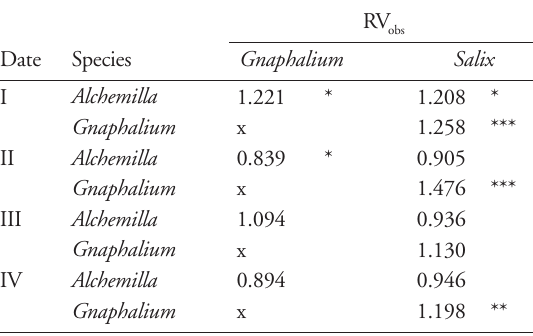
Table 5. Spatial relationships between the dominant snowbed species for each snowmelt date. Associations and dissociations were detected by calculating the observed variance ratio (RV ) obs and comparison to the null model with randomly distributed species occurrences. A value of RV = 1 means a random dis- obs tribution of species occurrences, values of RV < 1 suggest dis- obs sociation, RV > 1 indicate association. The dominant species: obs Alchemilla = A. pentaphyllea , Gnaphalium = G. supinum , and Sa- lix = S. herbacea . Significance levels: * (p < 0.05), ** (p < 0.01), and *** (p < 0.001). Snowmelt dates (date): I = 2 Jun 2003,